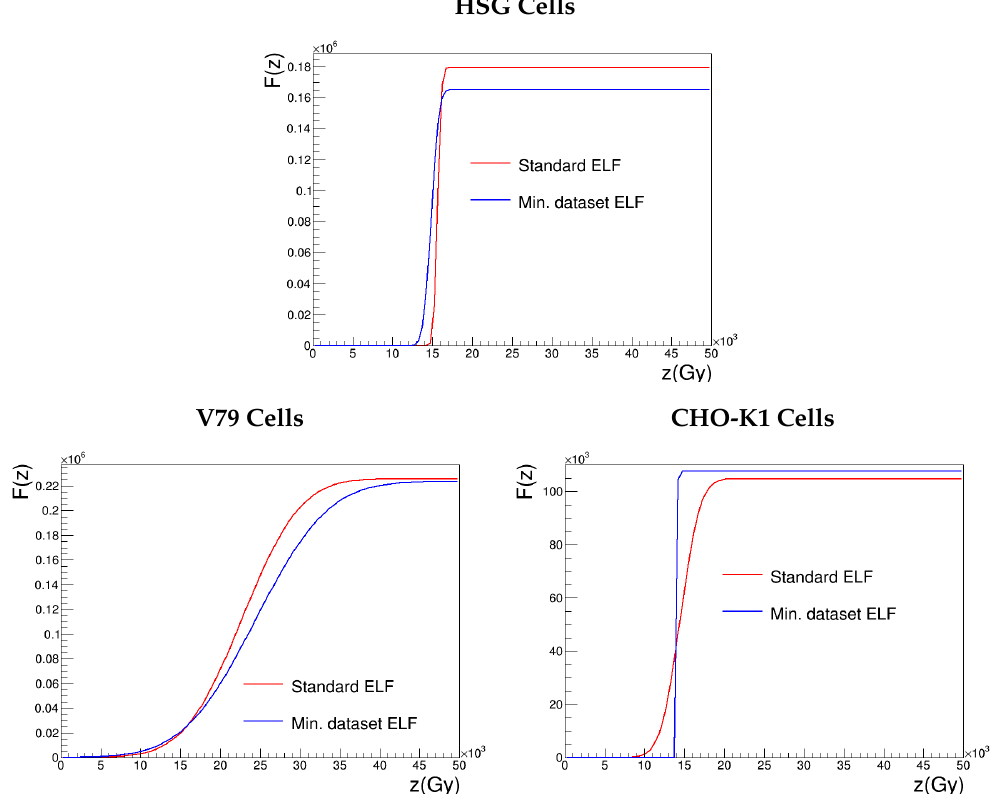
Figure 1. Effective lethal functions optimized considering the standard dataset or the minimal dataset; the latter consists of α ( LET ) values corresponding to irradiations with photons, one carbon ion with LET between 55 and 75 keVµm − 1 and one carbon ion with LET between 150 and 200 keVµm − 1